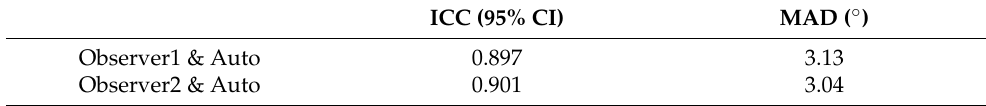
Table 4. Consistency analysis of Cobb Angle automatic measurement and manual